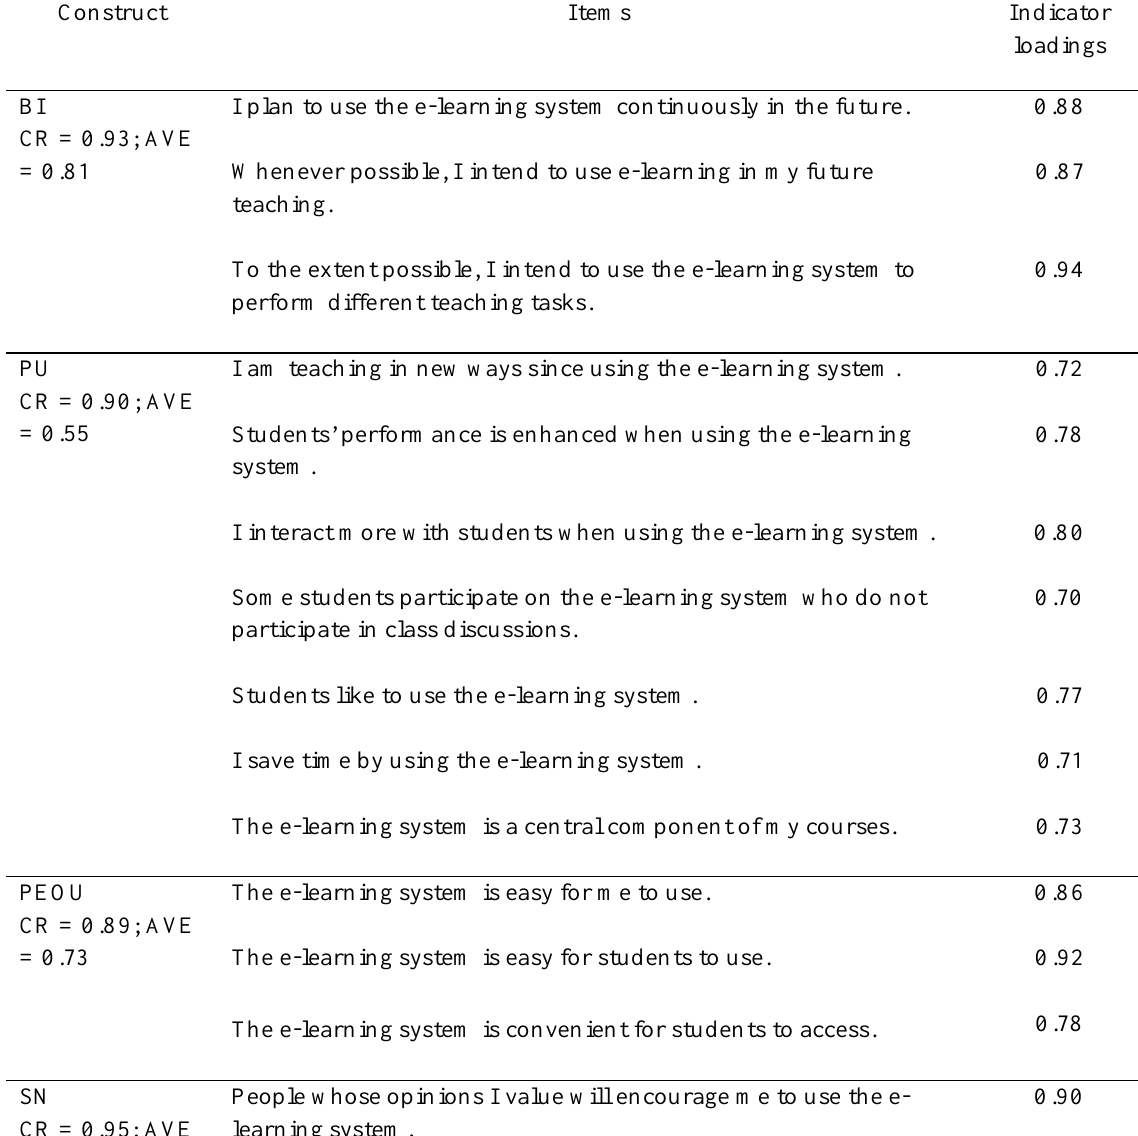
Results of Measurement